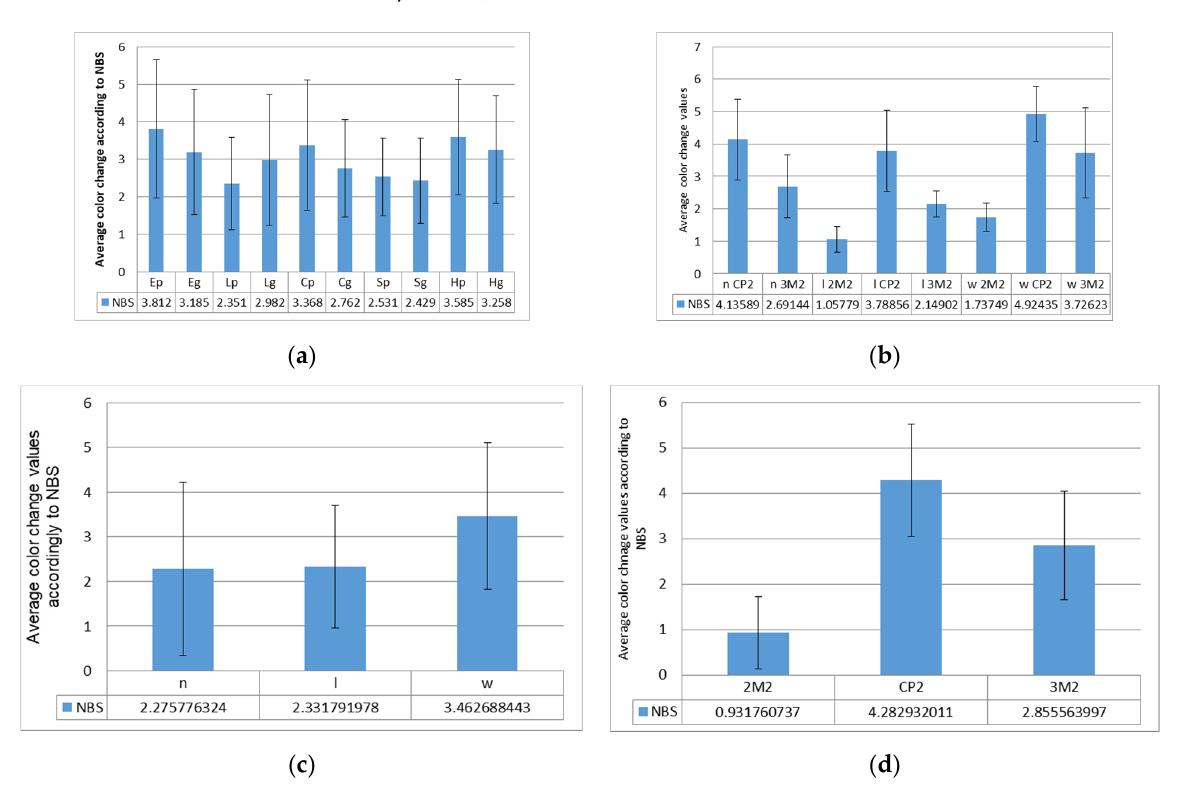
Figure 2. Average color changes and SD, related to ( a ) restoration material, ( b ) luting material/sub- strate, ( c ) luting material, and ( d )